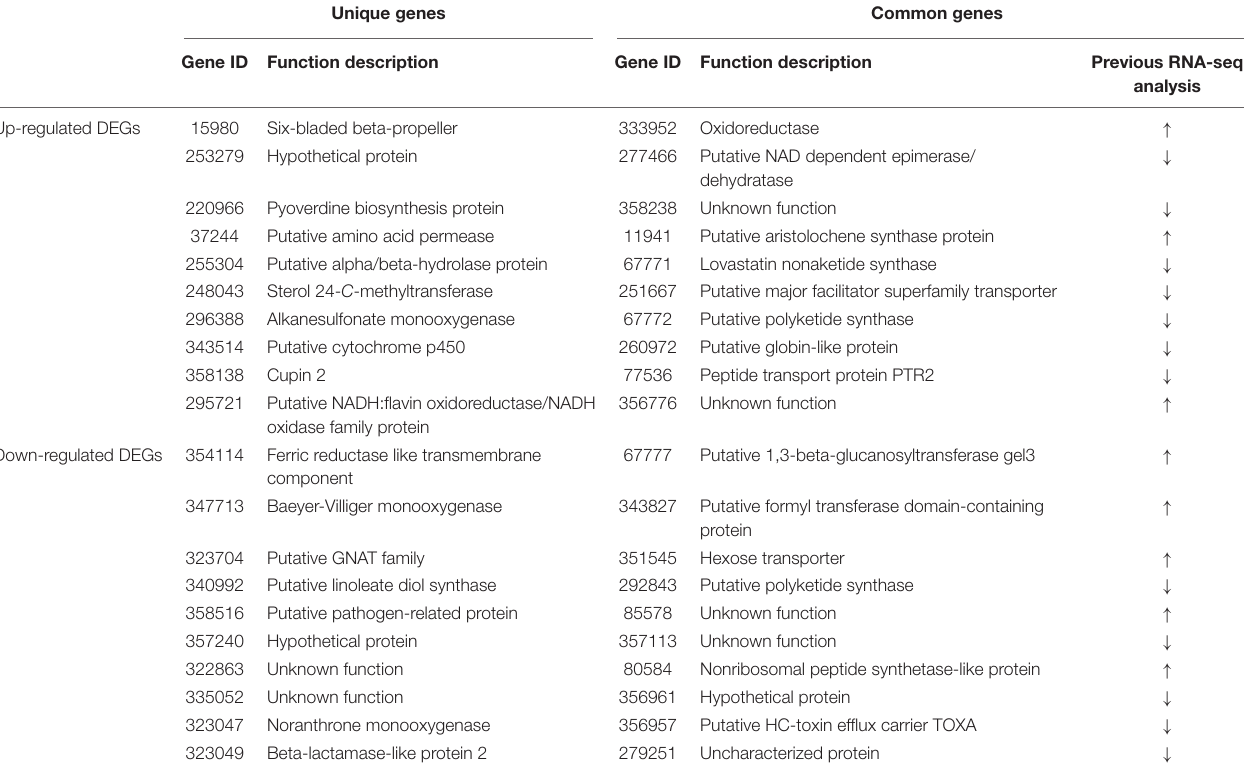
TABLE 3 | List of unique and common DEGs showing the highest expression compared to a previous RNA-seq study (Li et al.,